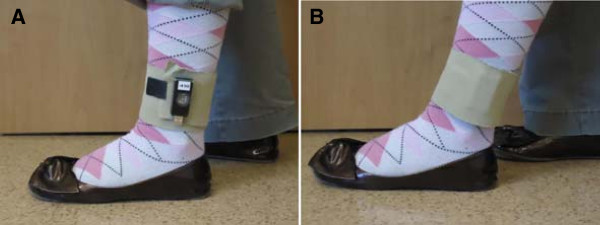
The ABLE accelerometers. The ABLE accelerometer as affixed to the ankle above the lateral malleolus. Model X6-2mini is shown. In panel A, the accelerometer is exposed to show its size. In panel B, the accelerometer is covered by the foam wrap; this is how the accelerometers are affixed in practice.